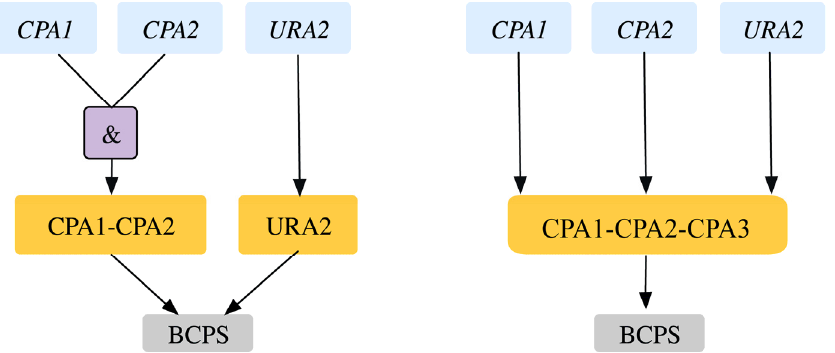
Figure 5. Gene-protein-reaction association for bifunctional carbamoyl phosphate synthase reaction. The genes (blue) code for the proteins (orange) that catalyze the reaction (gray). Old GPR is shown on the left and new GPR on the right.